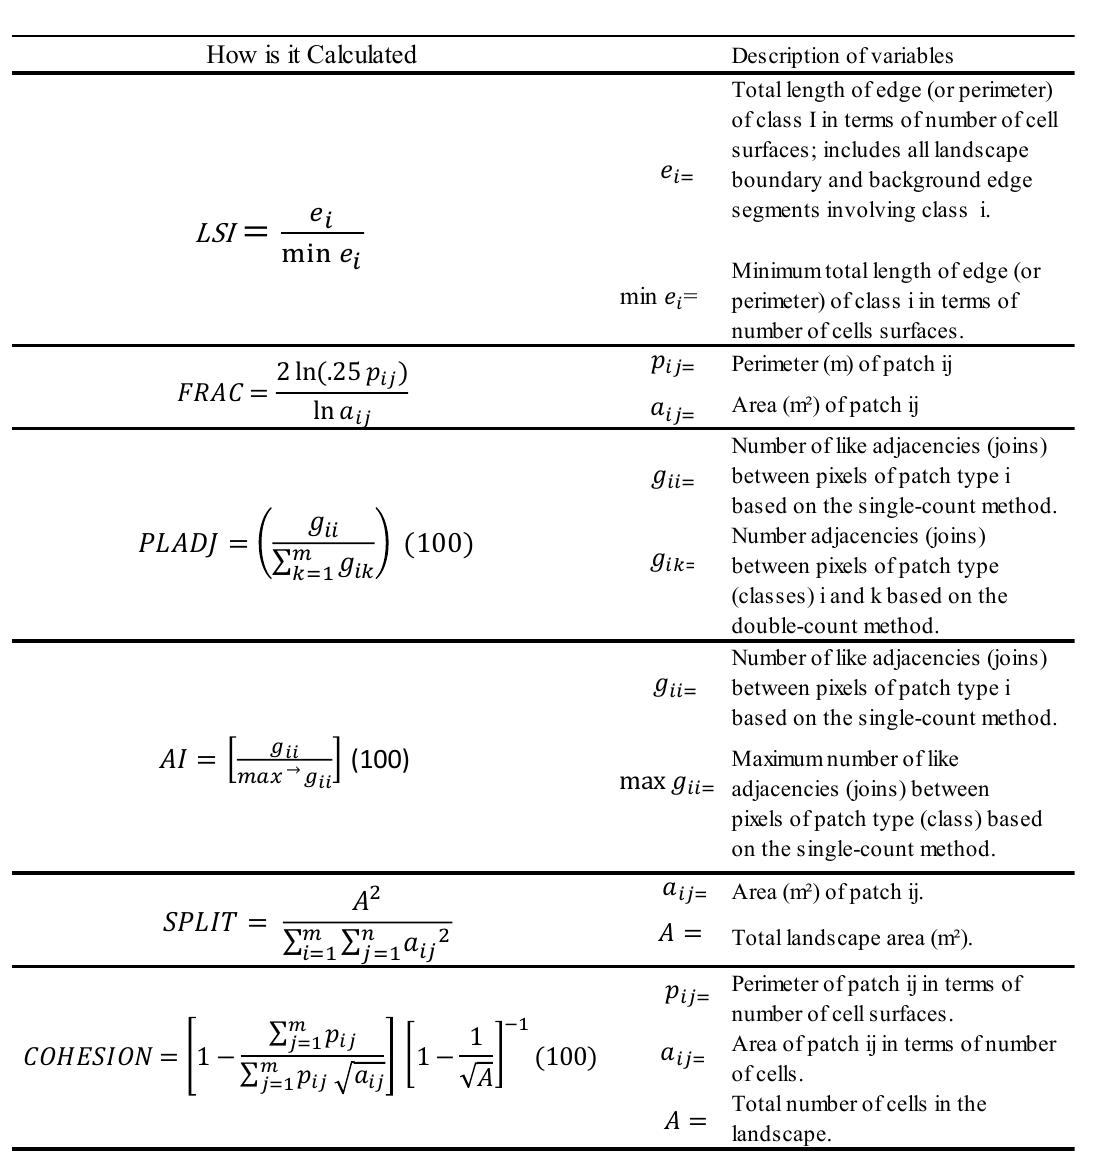
Figure A1. Detailed description of how the landscape indices are calculated.